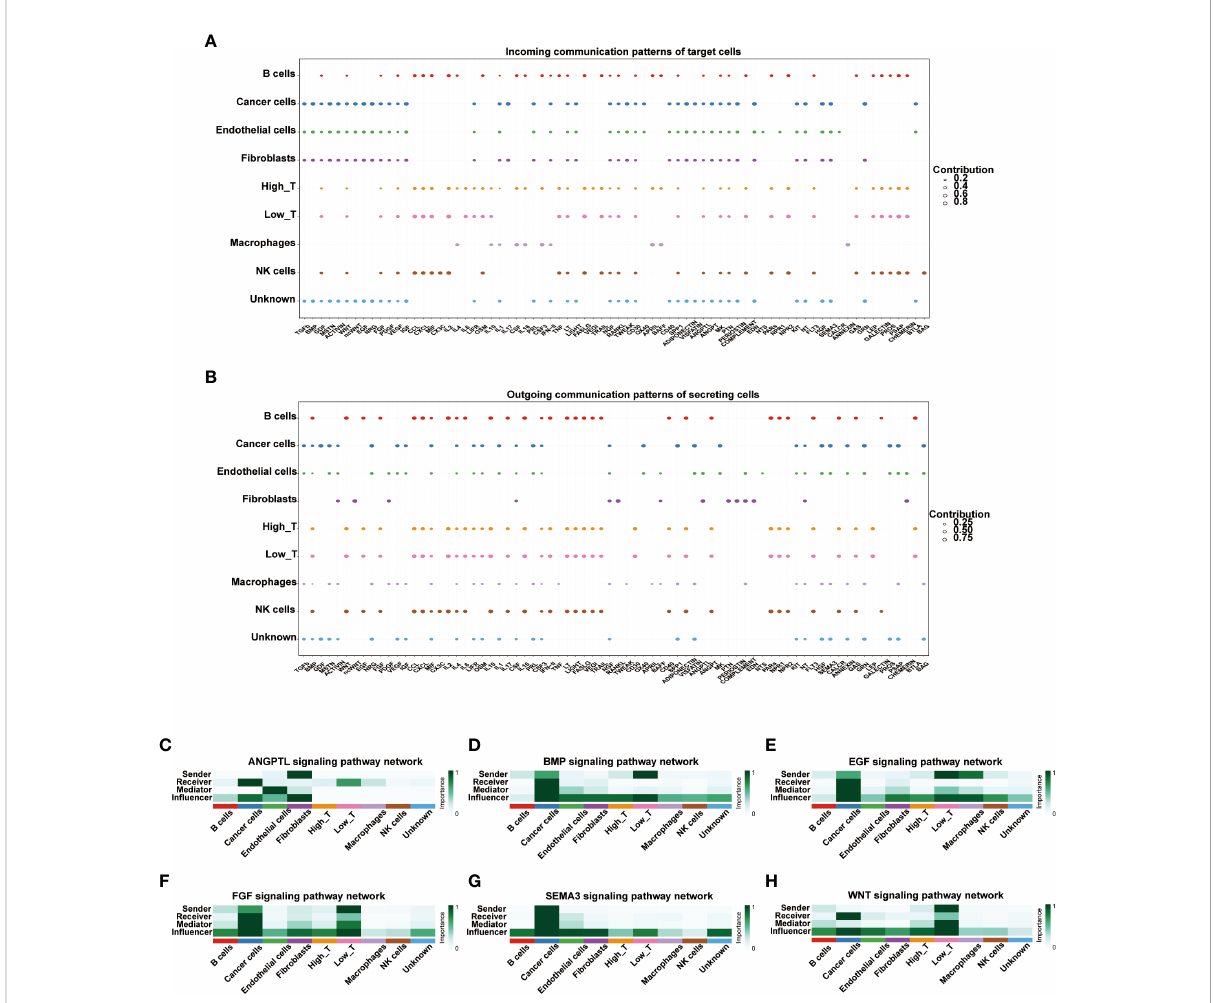
FIGURE 7 The dot plots depicted the receiver (A) and sender (B) communication patterns. The expression of CD161 is correlated with speci fi c signal pathways, including ANGPTL (C) , BMP (D) , EGF (E) , FGF (F) , SEMAS (G) , and WNT (H)